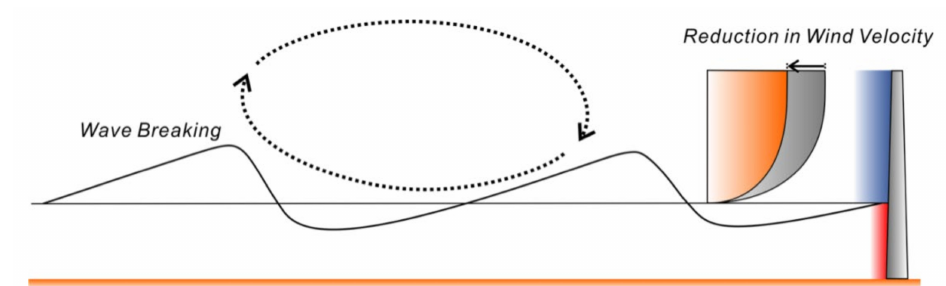
Figure 24. Schematic sketch of the reduction in the mean velocity over rough seas due to a coherent large eddy in the turbulent wind